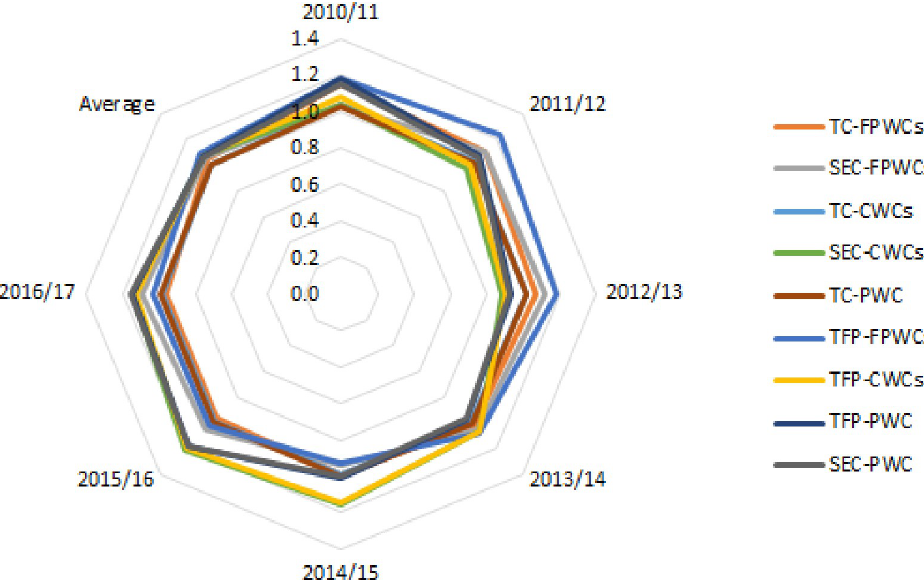
Fig 2. Total factor productivity change estimations and its drivers (technical change -TC- and scale efficiency change -SEC-) for Chilean full private water companies (FPWCs), concessionary water companies (CWCs) and public water company (PWC).